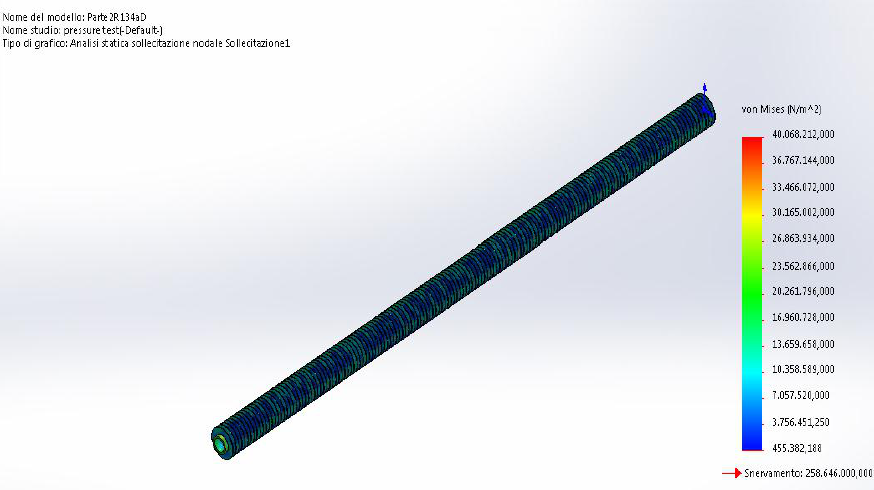
Figure 15. Diagram of mechanical stress with the Von Mises